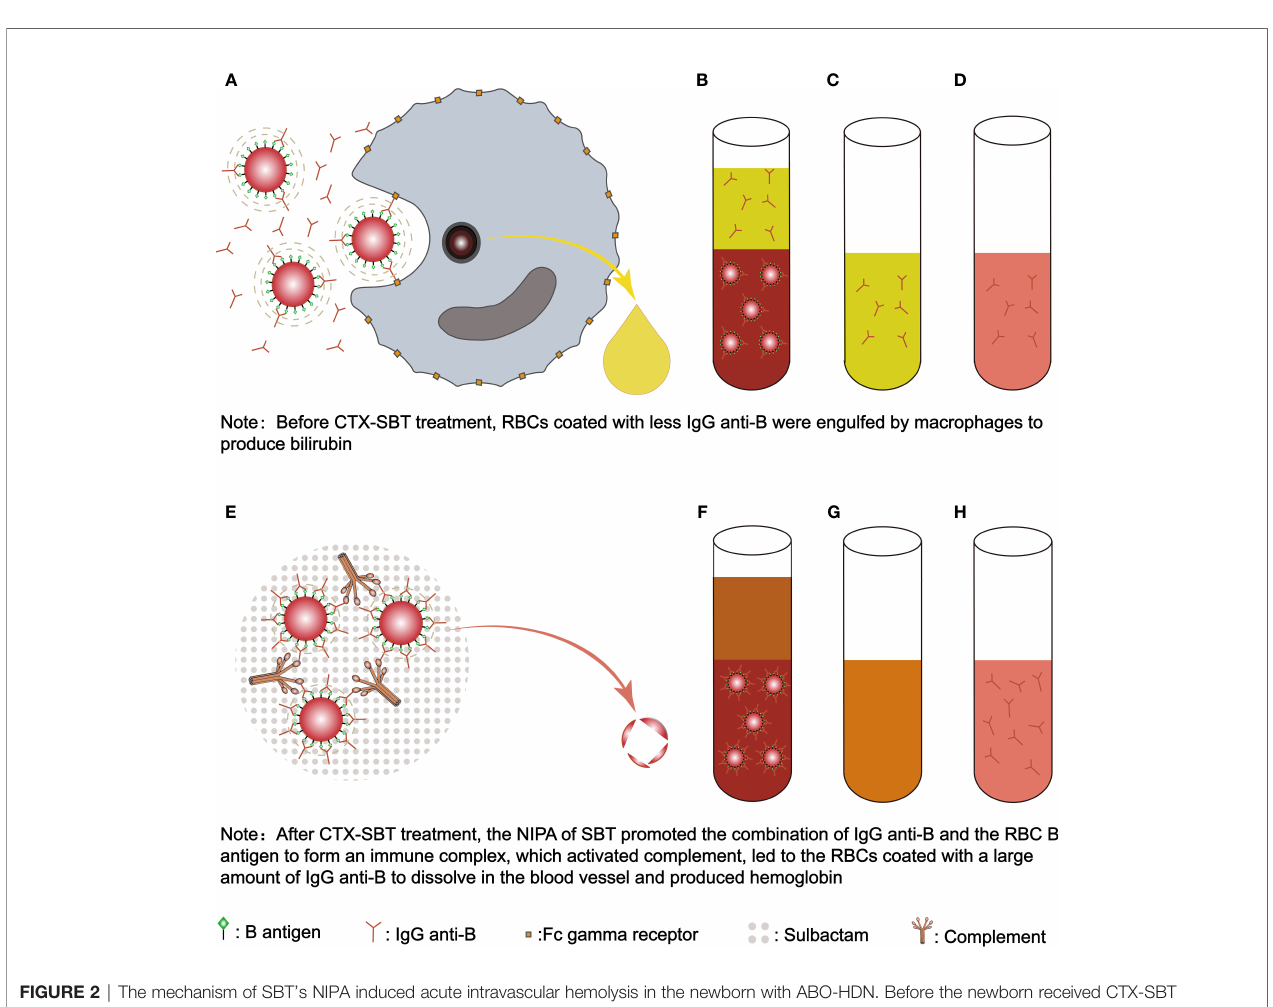
FIGURE 2 | The mechanism of SBT ’ s NIPA induced acute intravascular hemolysis in the newborn with ABO-HDN. Before the newborn received CTX-SBT treatment, RBCs coated with less IgG anti-B were engulfed by macrophages to produce bilirubin (A) . Since IgG anti-B were present in both plasma and RBCs (B) , the anti-globulin method was used to detect IgG anti-B in plasma (C) and RBC acid eluent (D) , the results were both positive (2+). Because the af fi nity between the newborn ’ s B antigen and IgG anti-B was low, and IgG anti-B bound to RBCs were less, it was not enough to activate complement, so the results of DAT for anti- IgG and anti-C3d were negative. After the newborn received CTX-SBT treatment, the NIPA of SBT promoted the combination of maternal IgG anti-B and the newborn ’ s RBC B antigen to form an immune complex, which activated complement, led to the RBCs coated with a large amount of IgG anti-B to dissolve in the blood vessel and produced hemoglobin (E) . Since the NIPA promoted almost all maternal IgG anti-B in plasma to bind to the newborn ’ s RBCs (F) , IgG anti-B cannot be detected in plasma (G) , while stronger IgG anti-B were detected in acid eluent (H) . Since enough IgG anti-B and C3d were bound to the newborn ’ s RBCs, the results of DAT for anti-IgG (3+) and anti-C3d (2+) were positive. Fc g Rn, Fc gamma receptor; SBT, sulbactam; CTX-SBT, cefotaxime sodium - sulbactam sodium combination; RBC, red blood cell; RBCs, red blood cells; NIPA, non-immunologic protein adsorption; DAT, direct antiglobulin test; ABO-HDN, ABO blood type incompatibility hemolytic disease of